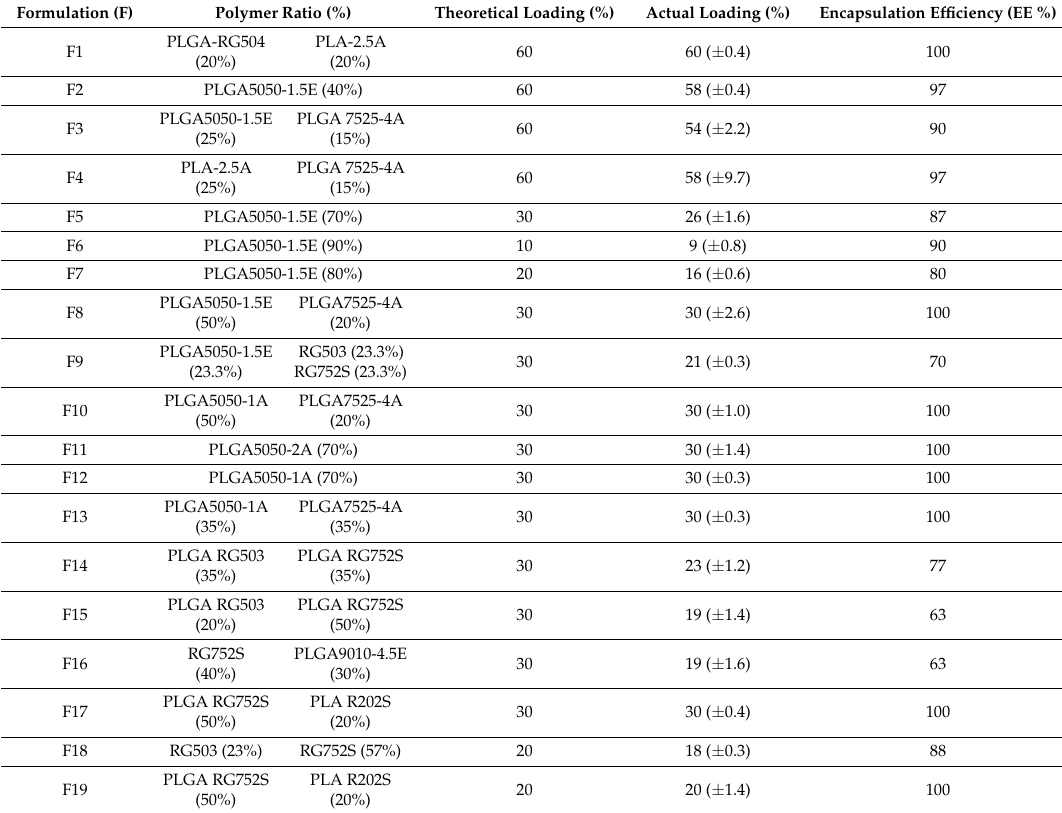
Table 2. Ketamine-loaded microparticles—formulations and incorporation efficiency. Formulation